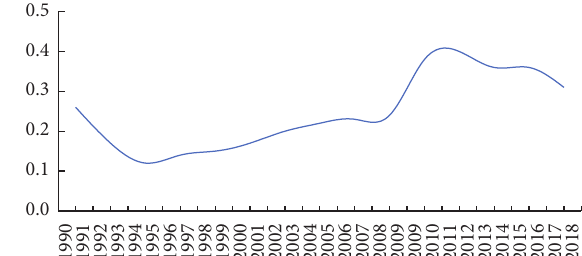
Figure 6: Global Moran’s I of county-level GDPPC in Xinjiang,